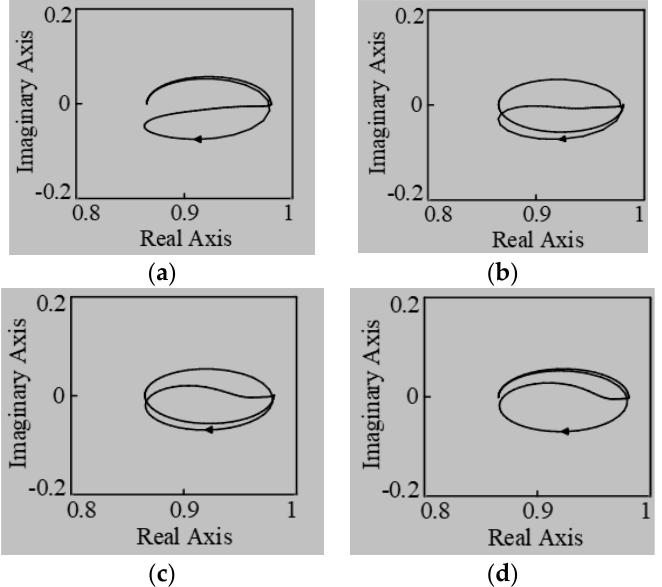
Figure 10. Trajectory of G F (e jwTs ) with different Lg. ( a ) Lg = 0mH. ( b ) Lg = 1mH. ( c ) Lg = 3mH. ( d ) Lg = 5mH.